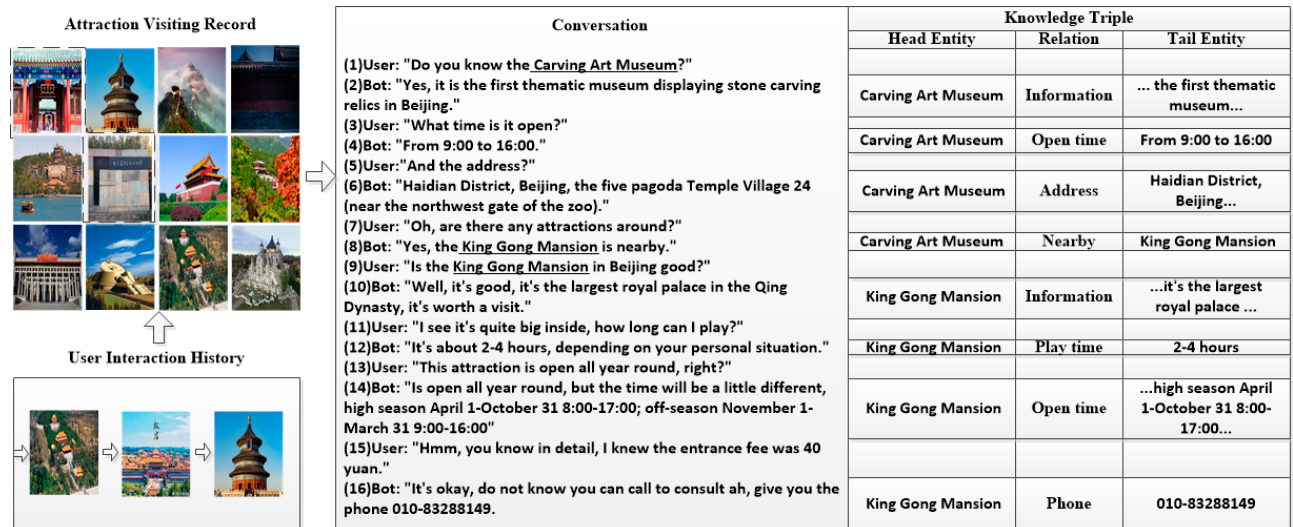
Figure 5. An illustrative example from the KdConvRec dataset. We selected two attractions (boxed by the dashed line) sharing the same category in the user interaction history from the visiting record that corresponded to the attractions (marked by underline) recommended by the conversation. The rightmost section shows the corresponding knowledge triplets.